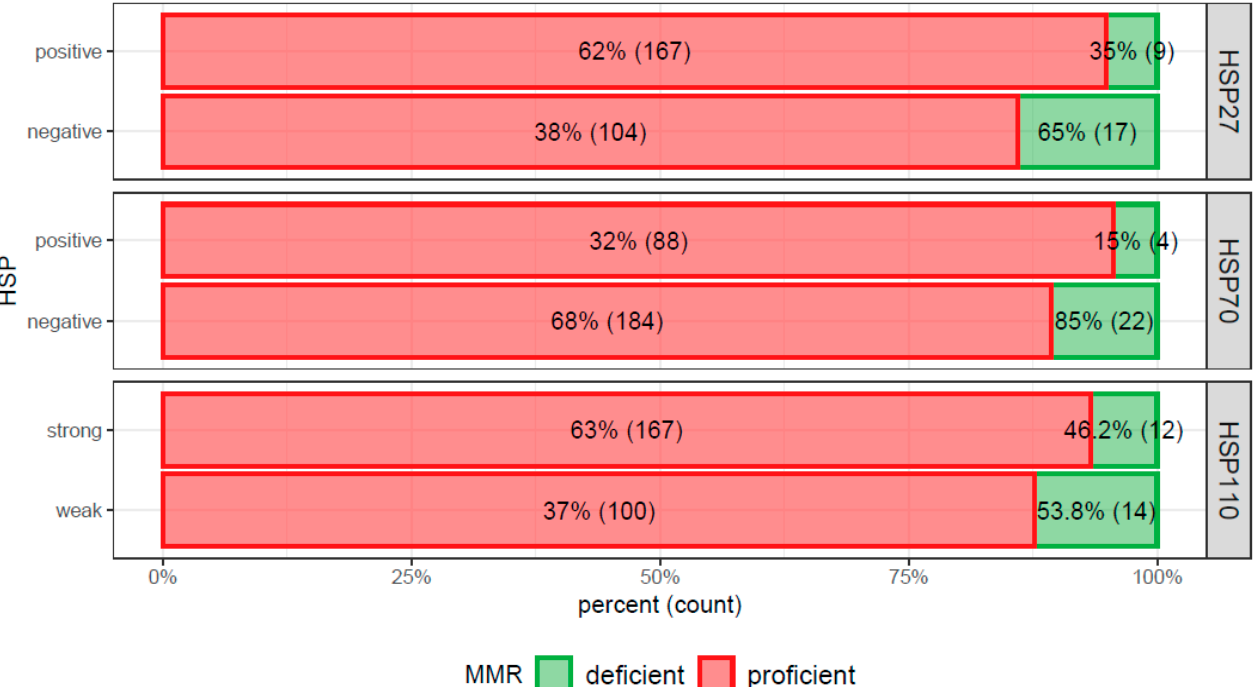
Figure 4. Bar chart documenting the Pearson’s chi squared test showing significantly more frequent expression of heat shock protein (HSP)27 ( p = 0.048) and HSP70 ( p = 0.005) in advanced stage colorectal cancer (Union for International Cancer Control III + IV stages). In the case of HSP110, there was no apparent association ( p = 0.836).